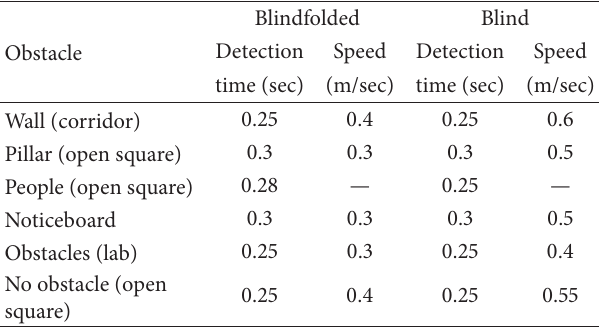
Table 3: Obstacle detection rate and comparison of blind and blindfolded